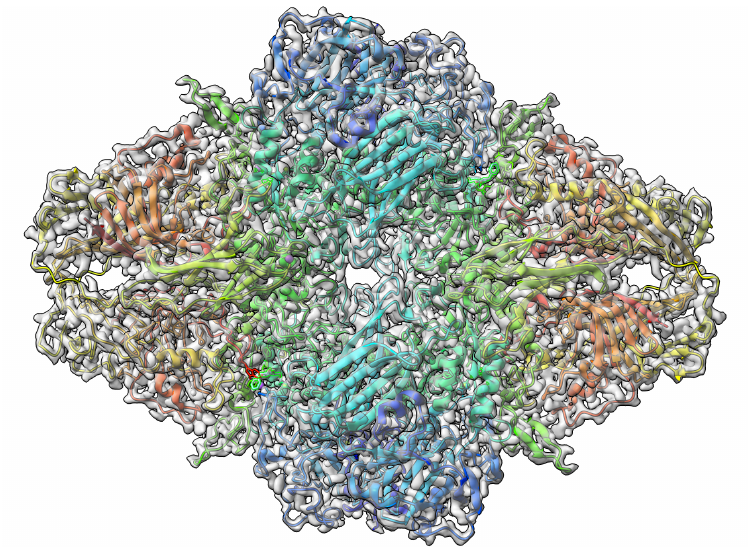
Figure 3. Target 201 (EMD-7770) map-model overlay at the recommended contour 0.52 (3.3 σ ) with T0201EM0004_1 (ours).